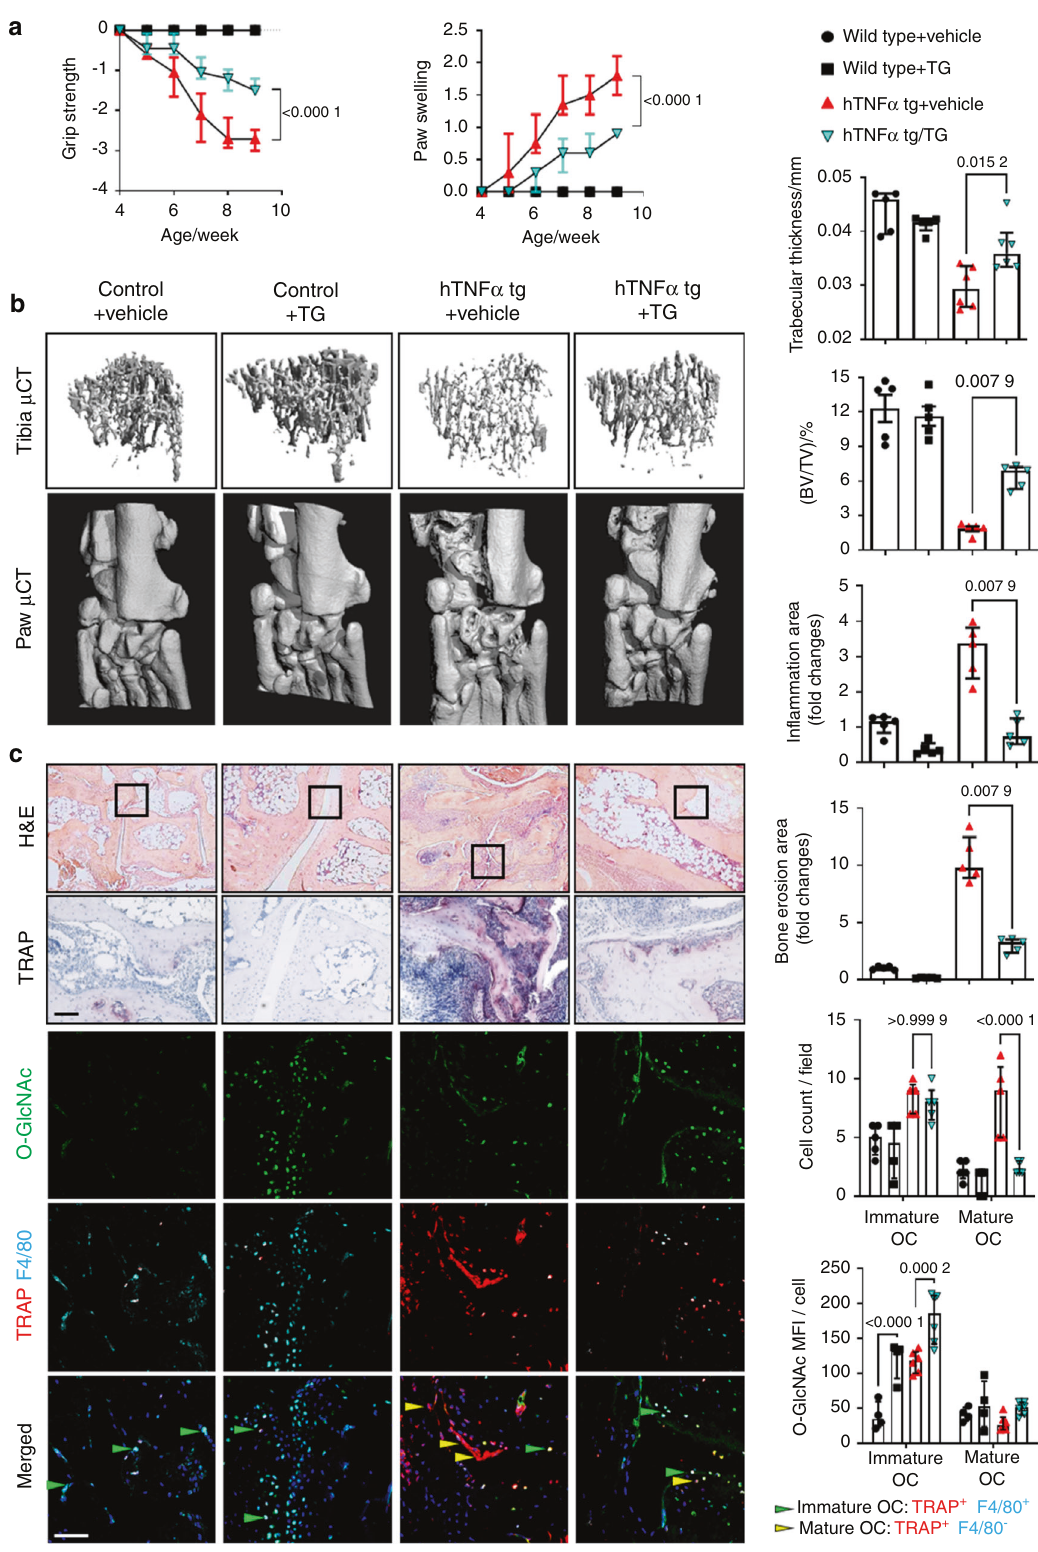
Fig. 5 Pharmacological inhibition of OGA ameliorates bone loss in human TNF α transgene mice. a Grip strength and joint swelling in hTNF α tg mice treated with Thiamet-G (TG). b Images and quanti fi cation of microcomputed tomography scans of bone tissue and analysis of the tibial bone structure. c Representative histological and confocal images of the tarsus with semi-automated, blinded quanti fi cation of H&E staining, TRAP staining, and O-GlcNAcylation. ( n ≥ 5 for all groups). All results are presented as median ± IQR. Horizontal scale bars are represented as 50 µm in IF images, 100 µm in histological staining. Statistical signi fi cance was determined by two-way ANOVA ( a , c ) or Mann – Whitney U-test ( b ). P -values are shown in the graphs. MFI mean fl uorescence intensity, OC